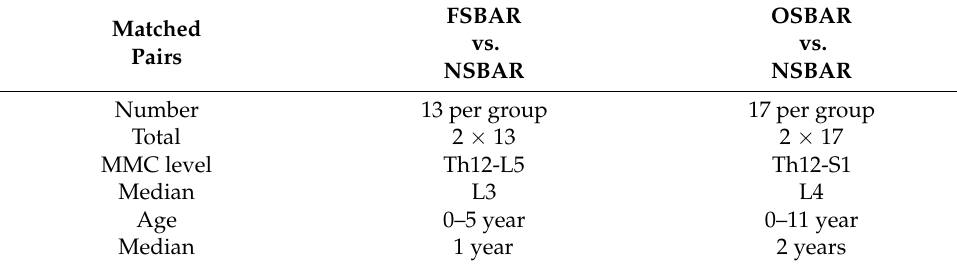
Table 2. Matched pairs for MMC level and postnatal age.